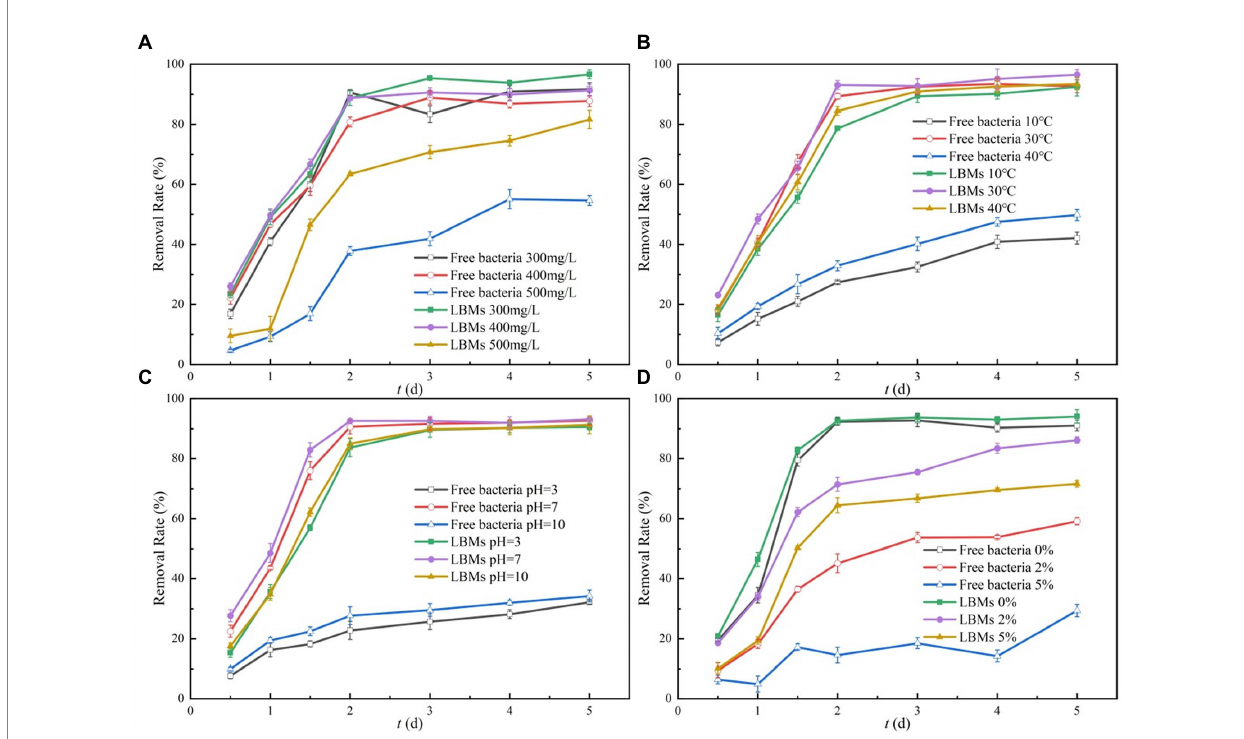
FIGURE 6 Effect of initial toluene concentrations (A) , temperature (B) , pH (C) , and salinity (D) on the toluene removal rate with